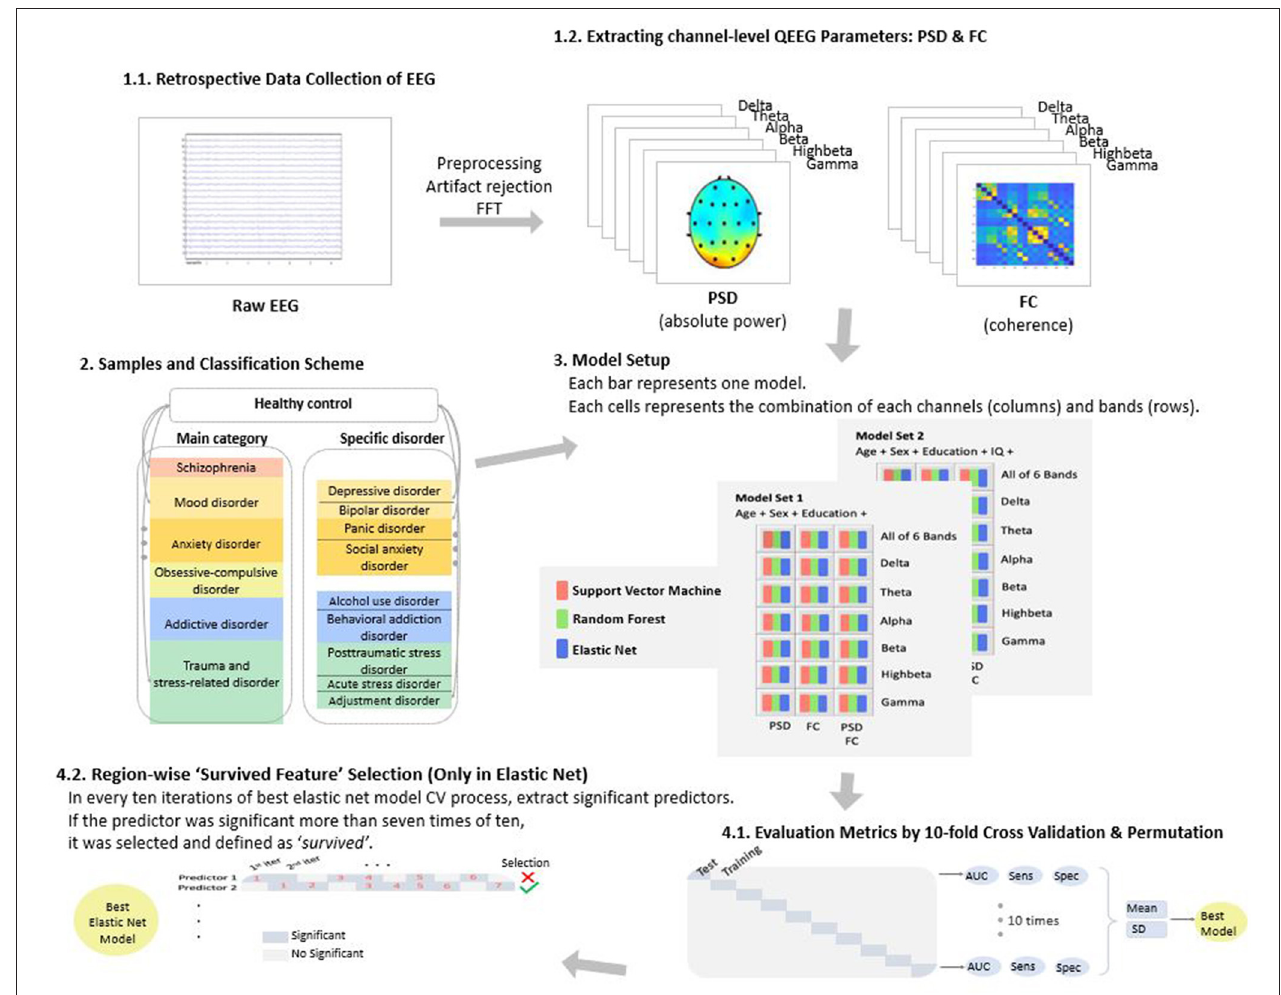
FIGURE 1 | Overview of the study. EEG, electroencephalography; QEEG, quantitative EEG; PSD, power spectrum density; FC, functional connectivity; and FFT, fast Fourier